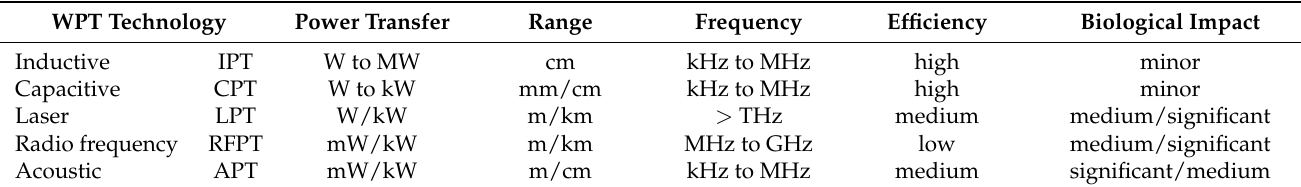
Table 1. Baseline characteristics of different wireless power transfer technologies.